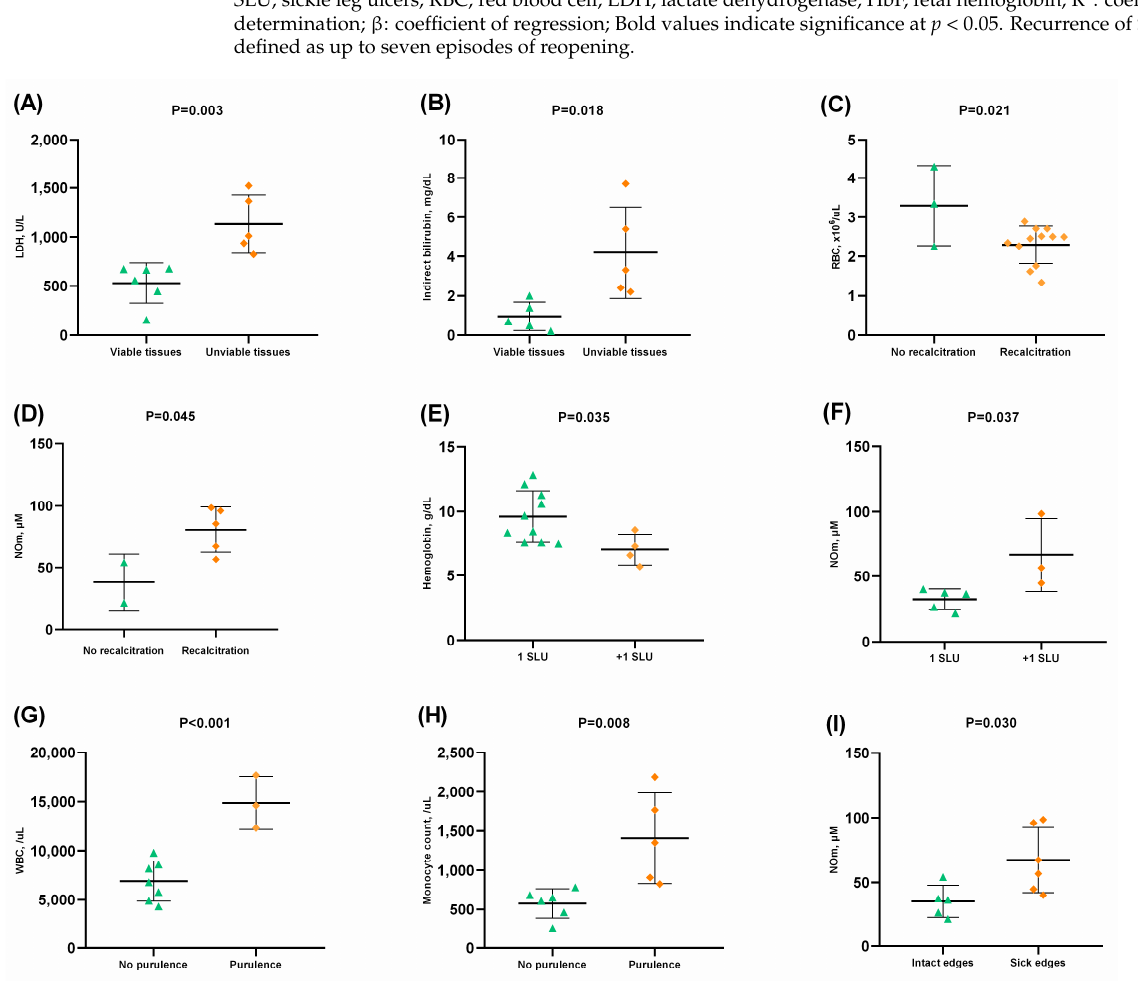
Figure 3. Associations between laboratory biomarkers and clinical characteristics of active sickle leg ulcers (SLU). ( A ) Higher lactate dehydrogenase (LDH) levels in SLU with unviable tissues; ( B ) Higher indirect bilirubin levels in SLU with unviable tissues; ( C ) Lower red blood cell (RBC) count in SLU with recalcitration (>6 months); ( D ) Higher nitric oxide metabolites (NOm) levels in SLU with recalcitration (>6 months); ( E ) Lower hemoglobin concentration in patients with more than one SLU; ( F ) Higher nitric oxide metabolites (NOm) levels in patients with more than one SLU; ( G ) Higher white blood cell (WBC) count in SLU with purulence; ( H ) Higher monocyte count in SLU with purulence; ( I ) Higher nitric oxide metabolites (NOm) levels in patients with sick edges in SLU. p -value obtained using independent t -test.